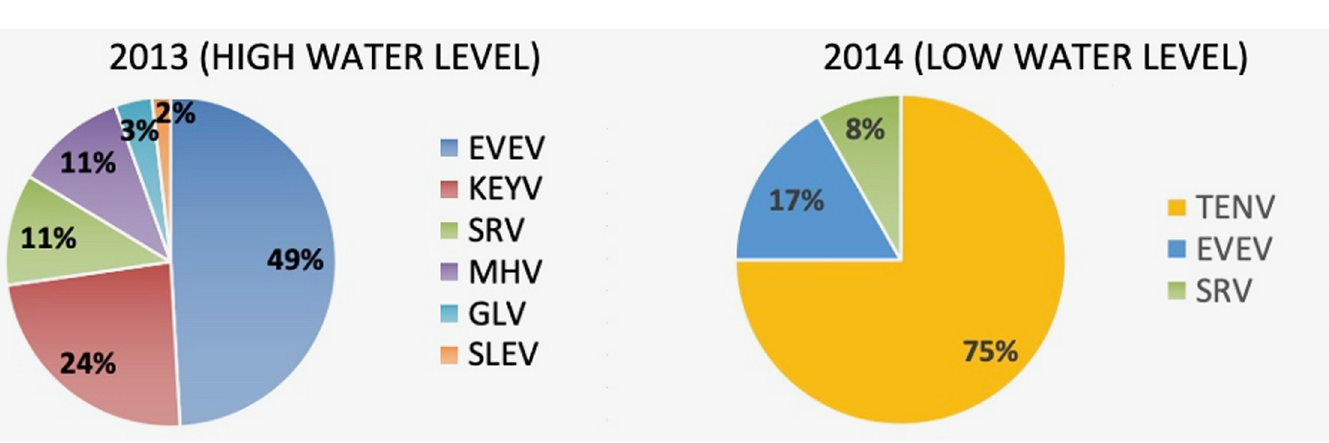
Fig 8. Arbovirus isolations. Composition of all vertebrate arboviruses isolated from mosquitoes in 2013 (N = 56/1037 pools) and 2014 (N = 12/973 pools).